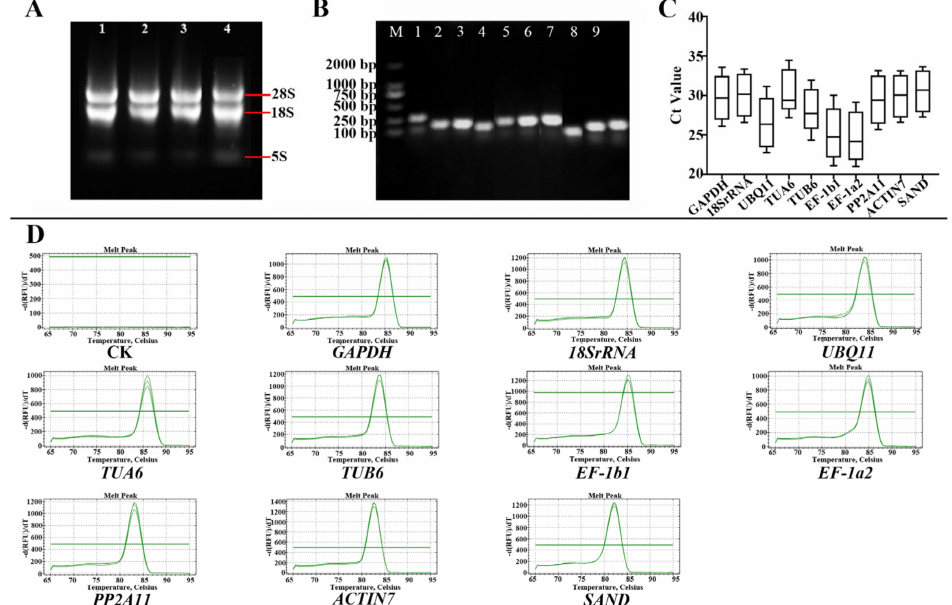
Figure 1. Specificity detection of primer amplification and gene expression analysis of candidate reference genes. ( A ) RNA gel figure of stele. 1–4, stele samples; ( B ) primer amplification specificity and amplification length of candidate RGs. M: marker; 1–10: ten candidate RGs in order are, GAPDH , 18SrRNA , UBQ11 , TUA6 , TUB6 , EF-1b1 , EF-1a2 , PP2A11 , ACTIN7 , and SAND ; ( C ) boxplot of Ct values of candidate internal reference genes. In the boxplot, each box represents the Ct value of the same reference gene at different concentrations. The horizontal line in the box represents the median, the upper and lower lines represent the upper and lower quartiles, and the upper and lower edges represent the maximum and minimum values of this group of data; ( D ) melting curves of the candidate reference gene. CK means control. Ct means cycle